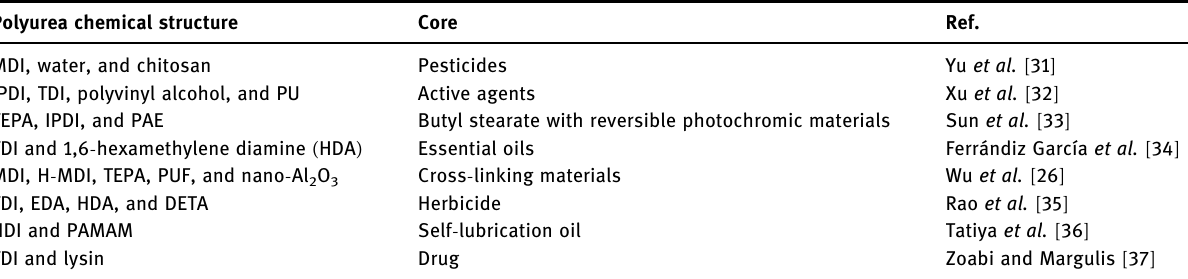
Table 1: Di ff erent raw materials for the synthesis of various polyurea micro - /nano - capsules Polyurea chemical